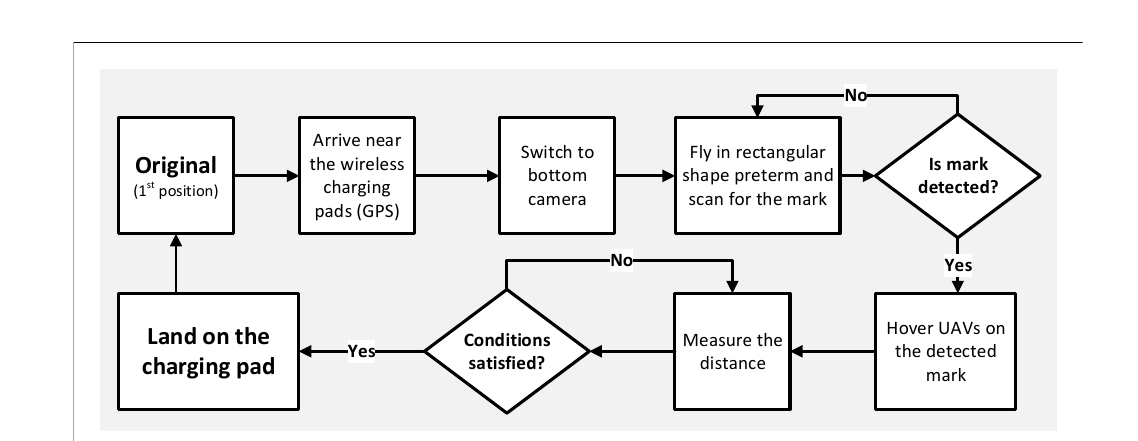
Figure 2. Automatic landing algorithm at the UAVs